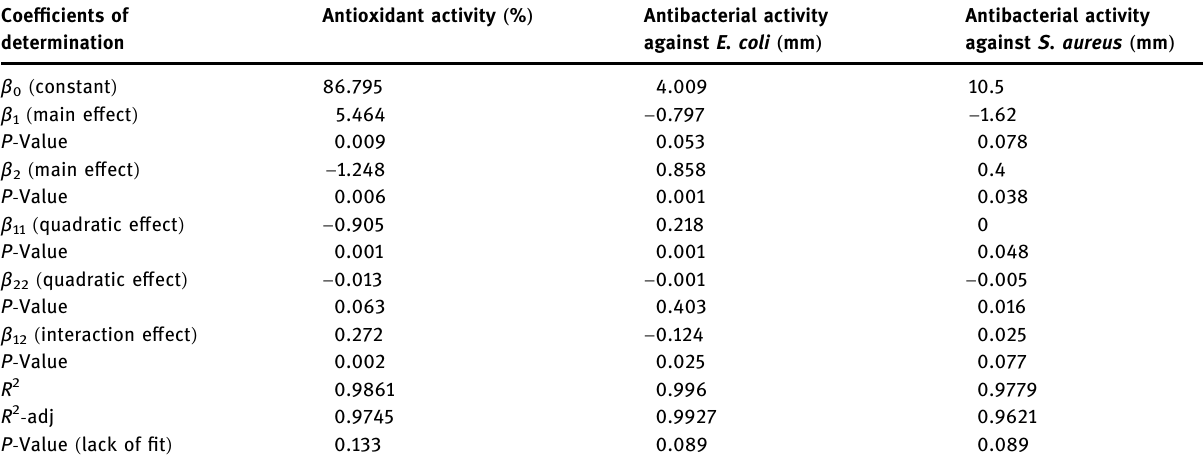
Table 2: Coe ffi cients of determination R 2 , R 2 - adj, lack of fi t ( P - value of the regression ) and ANOVA for the terms of the fi nal model based on the P -